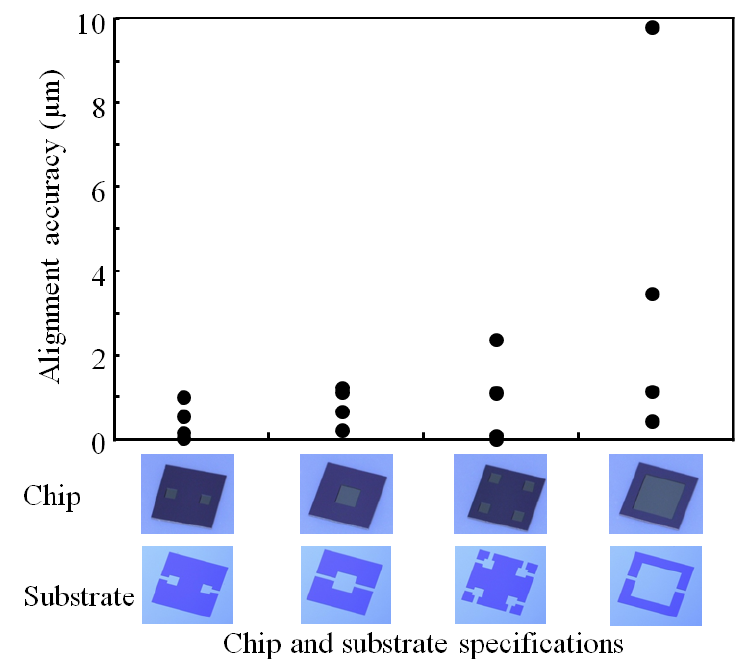
Figure 10. Effects of cavity size and the number of cavities on alignment